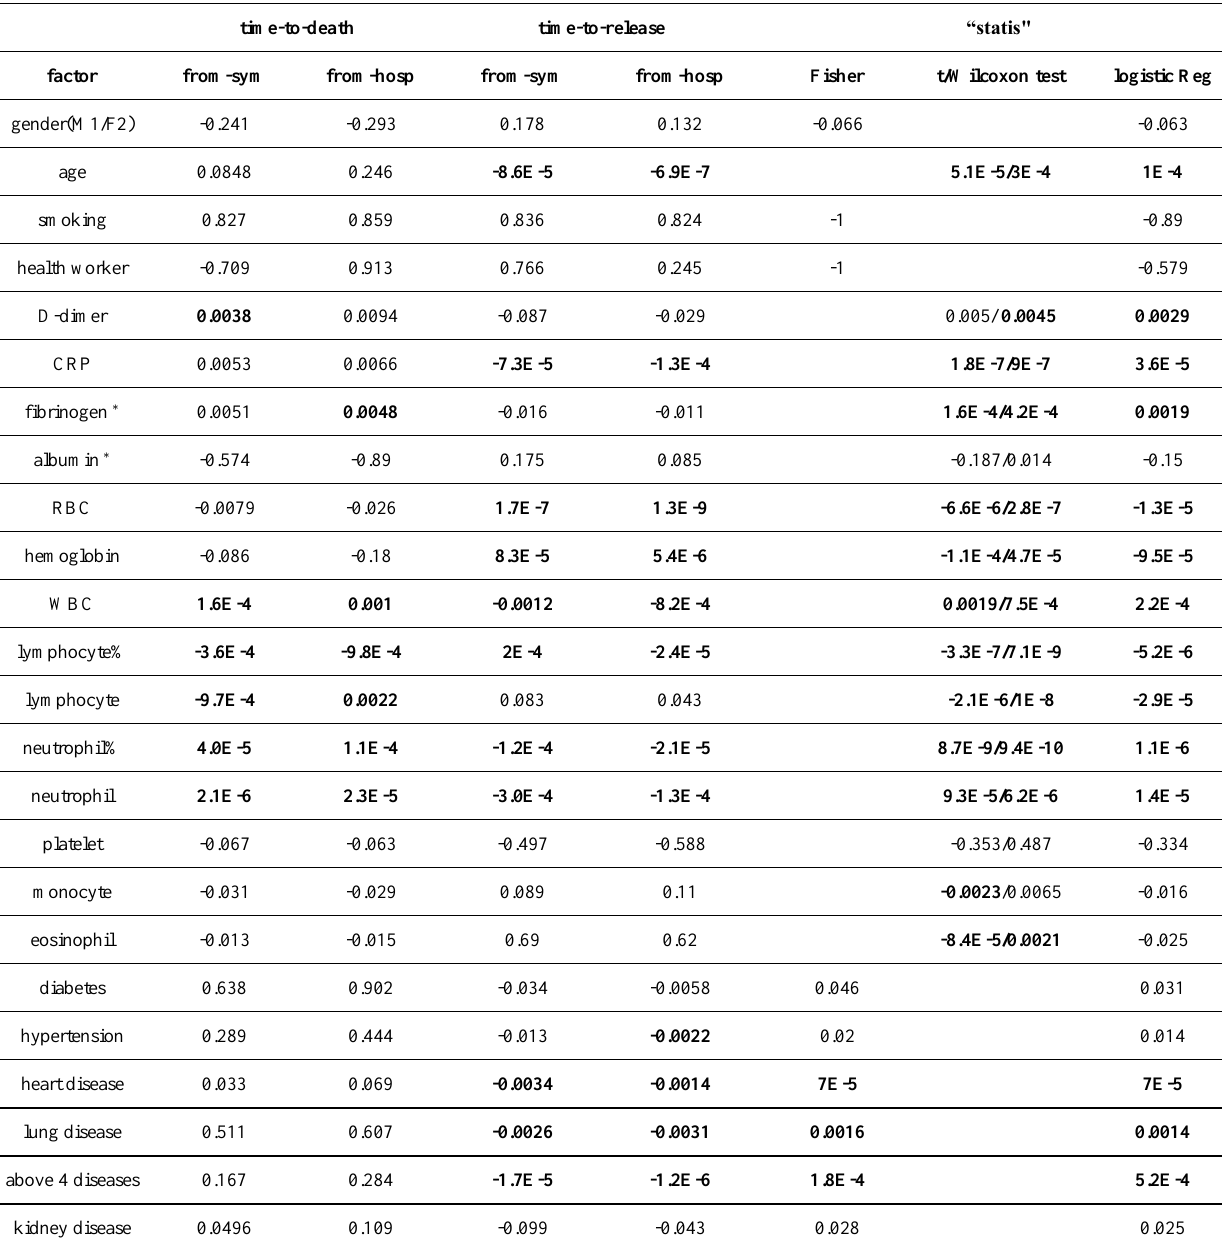
Table 1. P-values from three types of analyses (time-to-death survival analysis, time-to-release survival analysis, case- control analysis) and 6-7 tests (four Cox regressions, Fisher test for discrete factors, t-test/Wilcoxon-test for continuous factors, logistic regression) for various factors for COVID-19 patients. P-values smaller than 0.005 are marked with boldface. The sign attached is defined as following: for Cox regression, sign of the log(hazard ratio), for t-test/Wilcoxon test, sign of mean(death group) - mean(release group), for Fisher’s test, sign of log(odds-ratio) preferring high value in the death group, and for logistic regression, the sign of the regression coefficient. The fabrino and albumin factors are marked by asterisk because they have a very high missing data rate (54% and 67%). Test p-values (with a sign) of risk factor’s association with